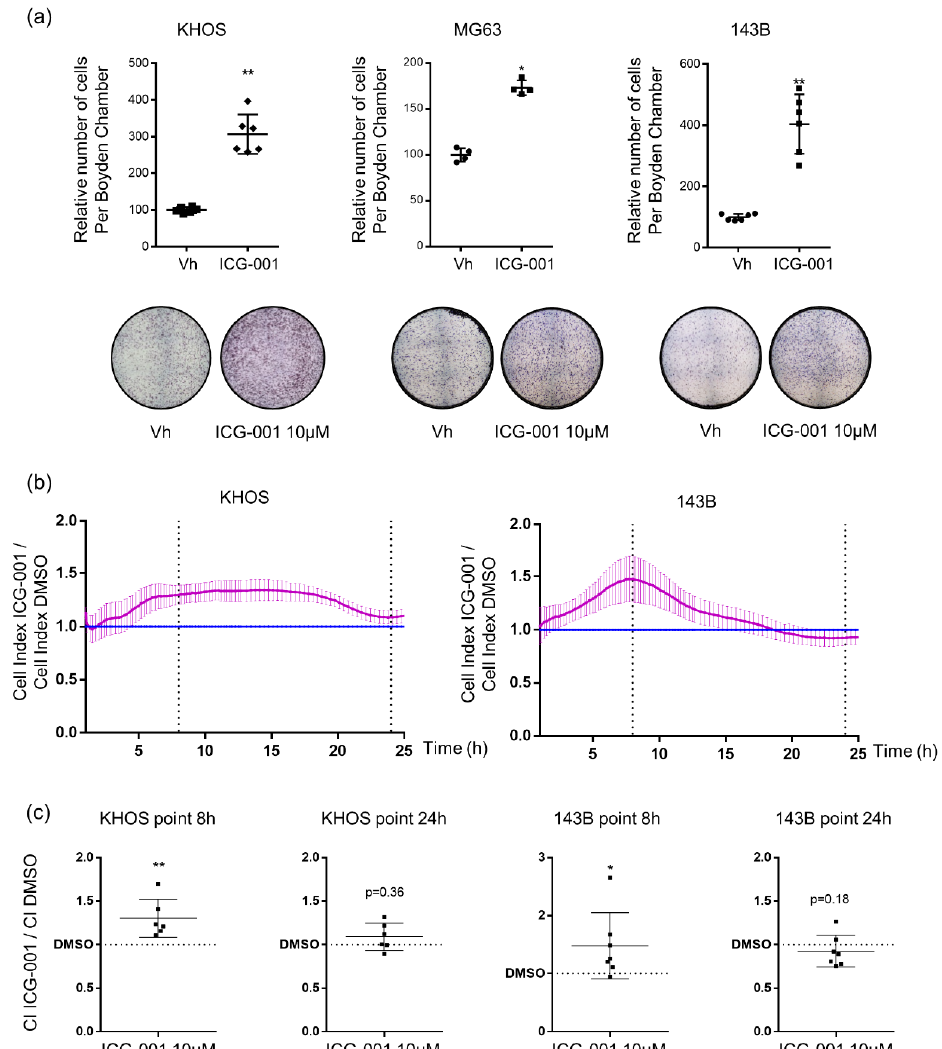
Figure 5. ICG-001 increases KHOS, MG63 and 143B osteosarcoma cell migration. ( a ) Migrated KHOS, MG63 and 143B cells counting after 24 h of ICG-001 (10 µM) or vehicle (Vh) pre-treatment and seeding in Boyden Chamber for 8 h. Bars represent means ± SD (KHOS n = 3; MG63 n = 2; 143B n = 3 each performed in duplicate). * p < 0.05; ** p < 0.01. ( b ) Real-time migration of KHOS and 143B cells after 24 h of ICG-001 (10 µM) or vehicle (Vh) and seeding in inserts of CIM plate. Curves represent means ± SEM of Cell Index (CI) of ICG-001 treated cells related to the CI of vehicle-treated cells, for three independent experiments, each performed in duplicate. ( c ) CI of ICG-001 treated cells relativized to CI of vehicle treated cells at 8 h and 24 h * p < 0.05; ** p < 0.01 vs. vehicle.